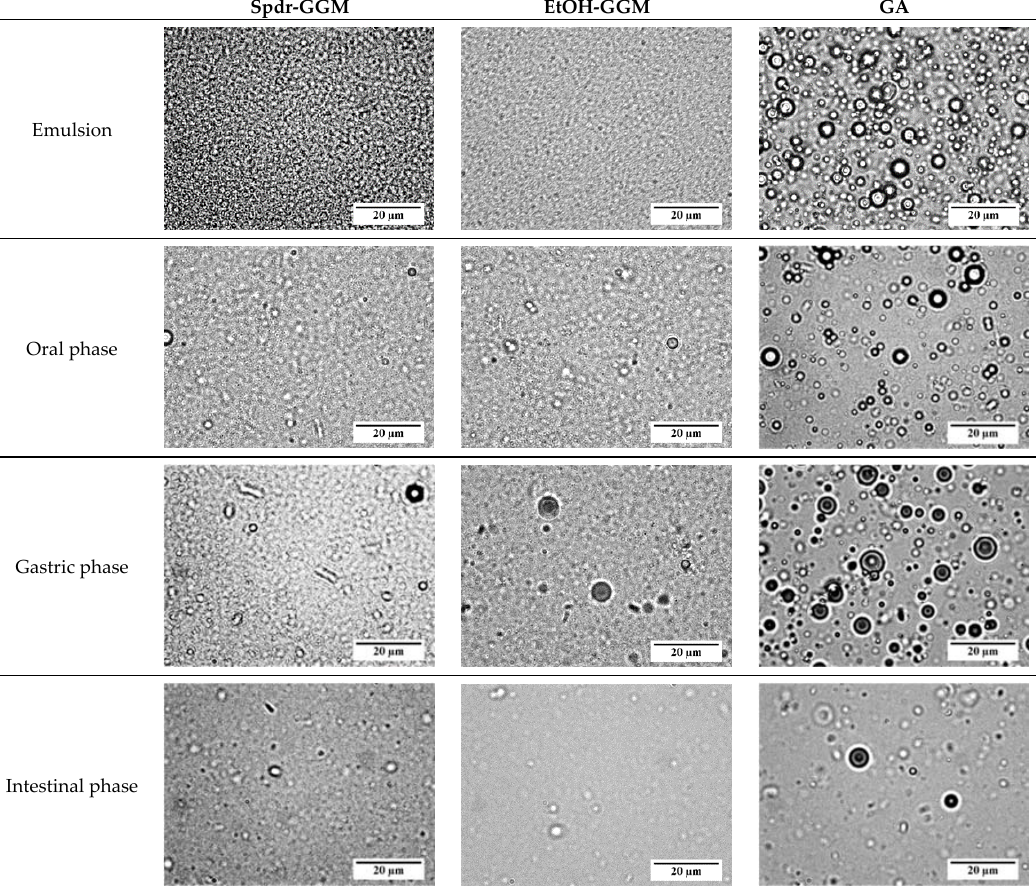
Figure 2. Optical microscopy images of Spdr-GGM-, EtOH-GGM-, and GA-stabilized emulsions before and after in vitro digestion.